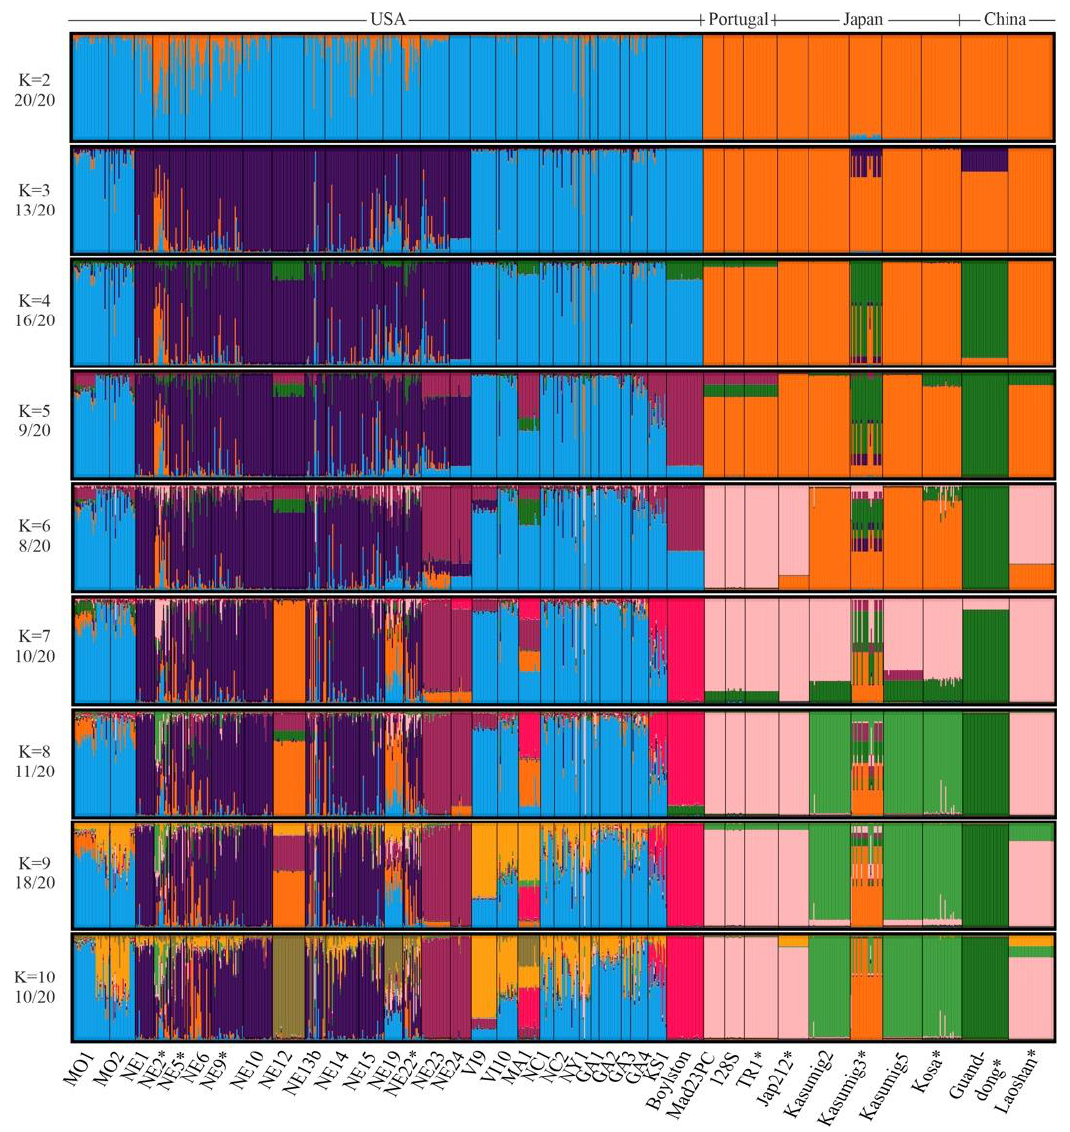
Figure 2: Genetic structure of the pinewood nematode samples used in this study. Bar plots of the coefficients of co-ancestry obtained in STRUCTURE analyses with several values of K . Each bar corresponds to one individual nematode and each cluster is represented with a particular color. The major clustering pa tterns are shown (see Figure S6B for the minor ones, when applicable). “*” indicates that the corresponding site sample was used in the ABC